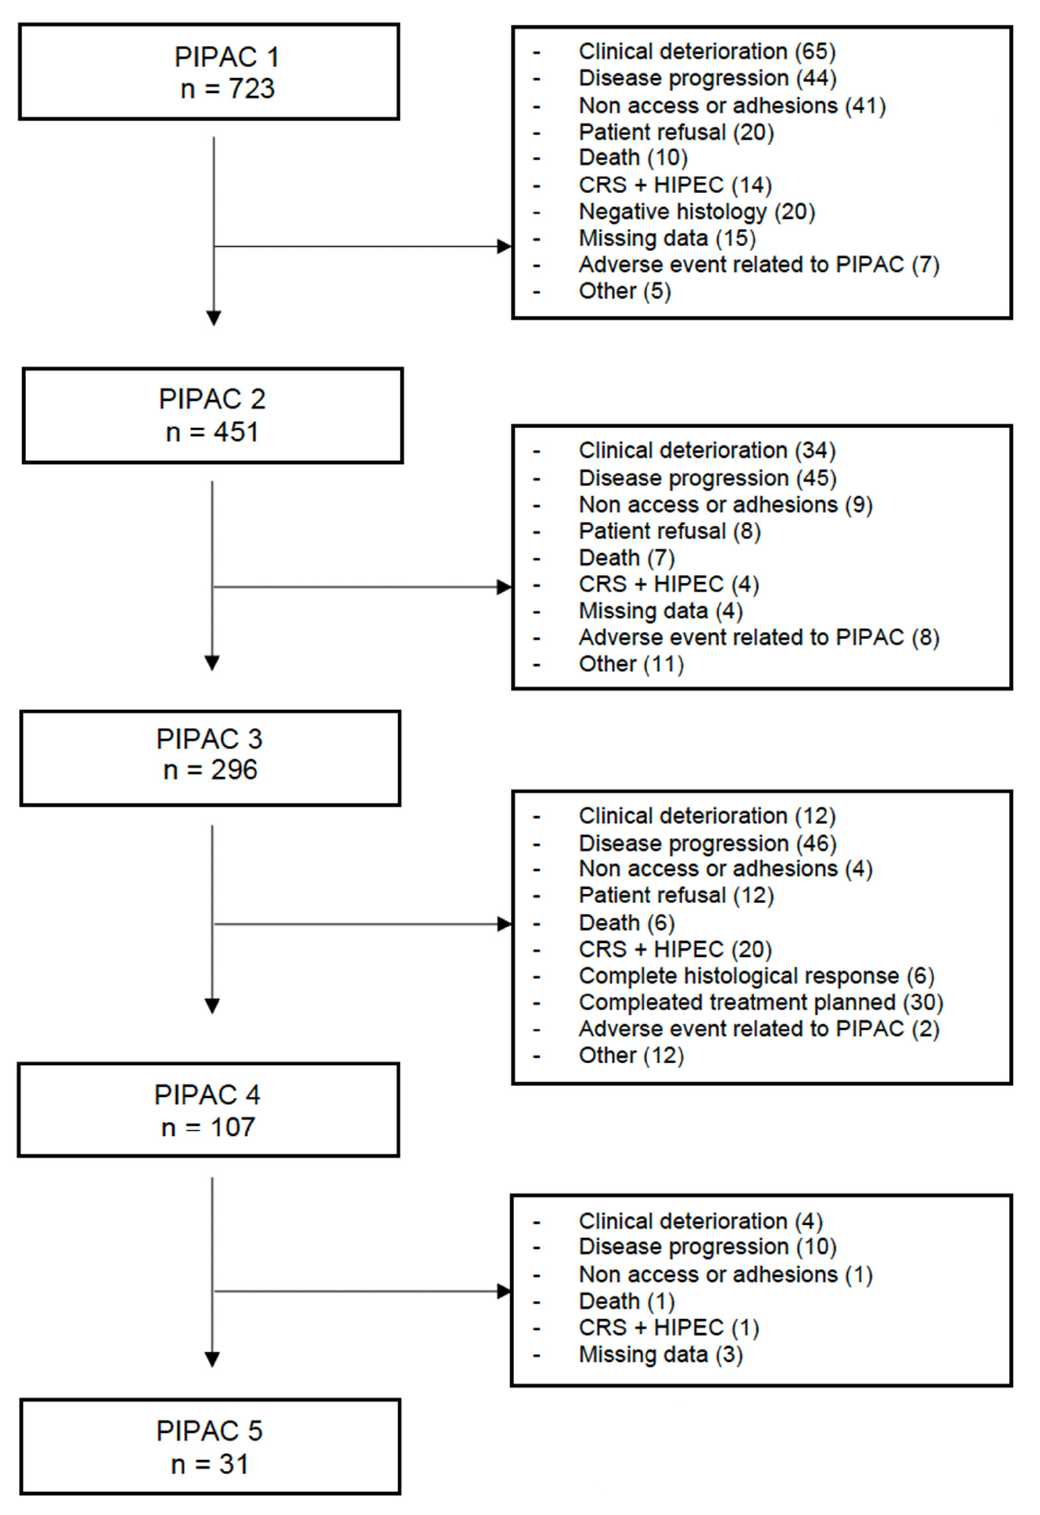
Figure 2. Flow chart of reasons of discontinuation of PIPAC.